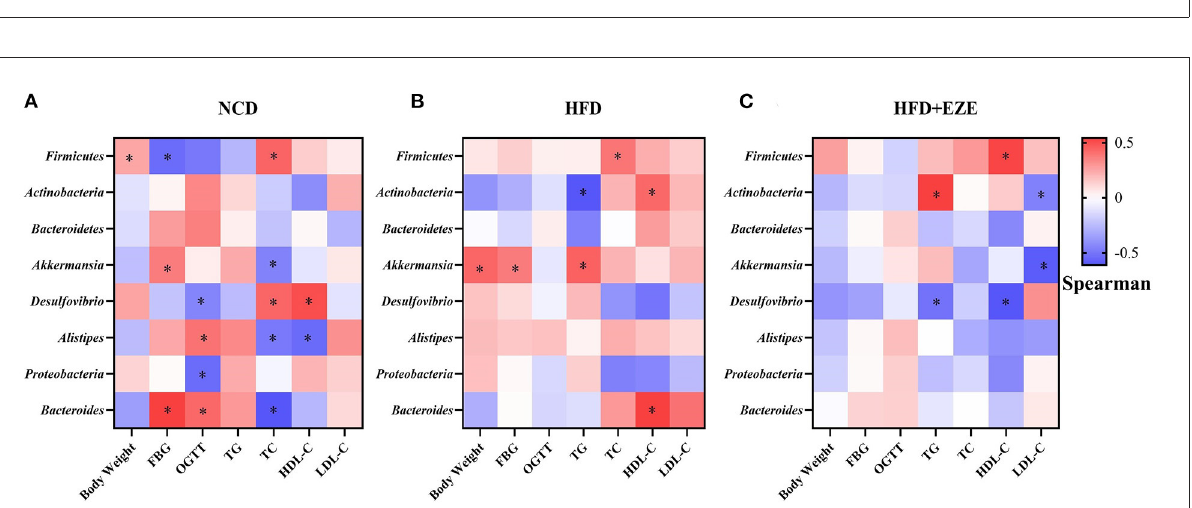
FIGURE7 Correlations between orlistat responsive core microbes and phenotypes. (A) Heatmap of the correlations between orlistat responsive core microbes and phenotypes in the NCD group. (B) Heatmap of the correlations between orlistat responsive core microbes and phenotypes in the HFD group. (C) Heatmap of the correlations between orlistat responsive core microbes and phenotypes in the HFD + ORL group. * Indicates that the correlations are statistically significant. Blue indicates the negative correlations, while red indicates the positive correlations. FBG, fasting blood glucose; OGTT, oral glucose tolerance test; TG, triglyceride; TC, total cholesterol; LDL-C, low-density lipoprotein-cholesterol; HDL-C, high-density lipoprotein-cholesterol.